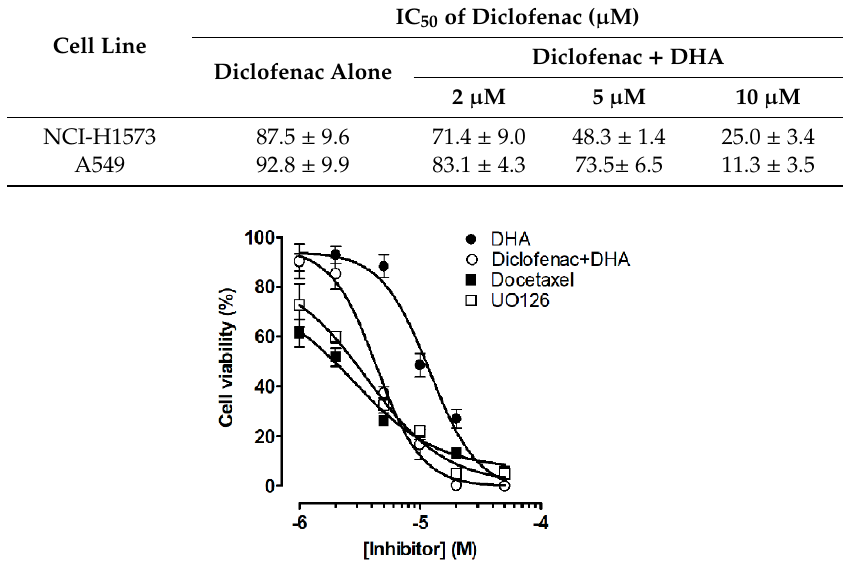
Figure 2. Comparing the e ff ectiveness of co-treatment of DHA and diclofenac with docetaxel and UO126 on the viability A549 human lung cancer cells. The e ff ects DHA ( • ) alone or with 25 µ M of diclofenac ( ) were compared to docetaxel ( (cid:4) ) and UO126 ( (cid:3) ) for 48 h. Cell viabilities were determined (cid:35) after the final treatment by fluorescence using the resazurin reduction assay. The IC 50 s were 11.1 ± 1.32 µ M, 4.38 ± 0.52 µ M, 2.82 ± 1.42 µ M, and 3.61 ± 1.2 µ M for DHA alone, DHA with diclofenac, docetaxel, and UO126, respectively. Each point represents the mean ± SEM relative to the control untreated